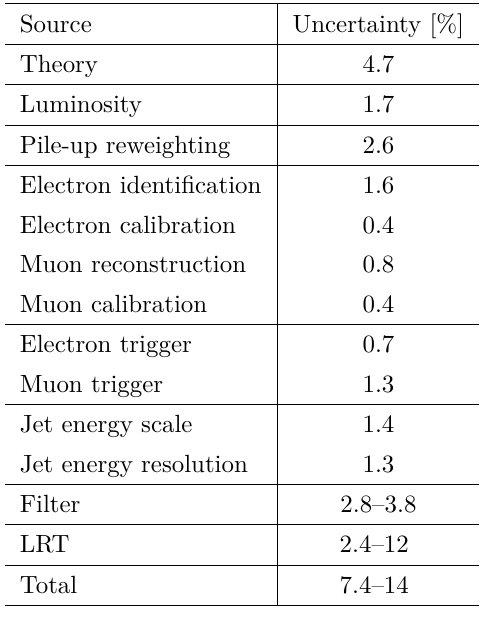
Table 2 . Summary of all sources of systematic uncertainty considered in the analysis that affect the signal yield. With the exception of the uncertainties from the filter and the LRT algorithm, no significant dependence on m a or cτ a is observed, so the quoted values are those derived from averaging over the different masses and lifetimes. The uncertainty from the filter efficiency was found to be uncorrelated with cτ a but to increase with m a , so the range quoted corresponds to the observed variation as m a increases, after averaging over cτ a . The uncertainty from the LRT algorithm was found to be correlated with both cτ a and m a , so the quoted range corresponds to the observed variation with m a and cτ a (with the uncertainty increasing most strongly with cτ a